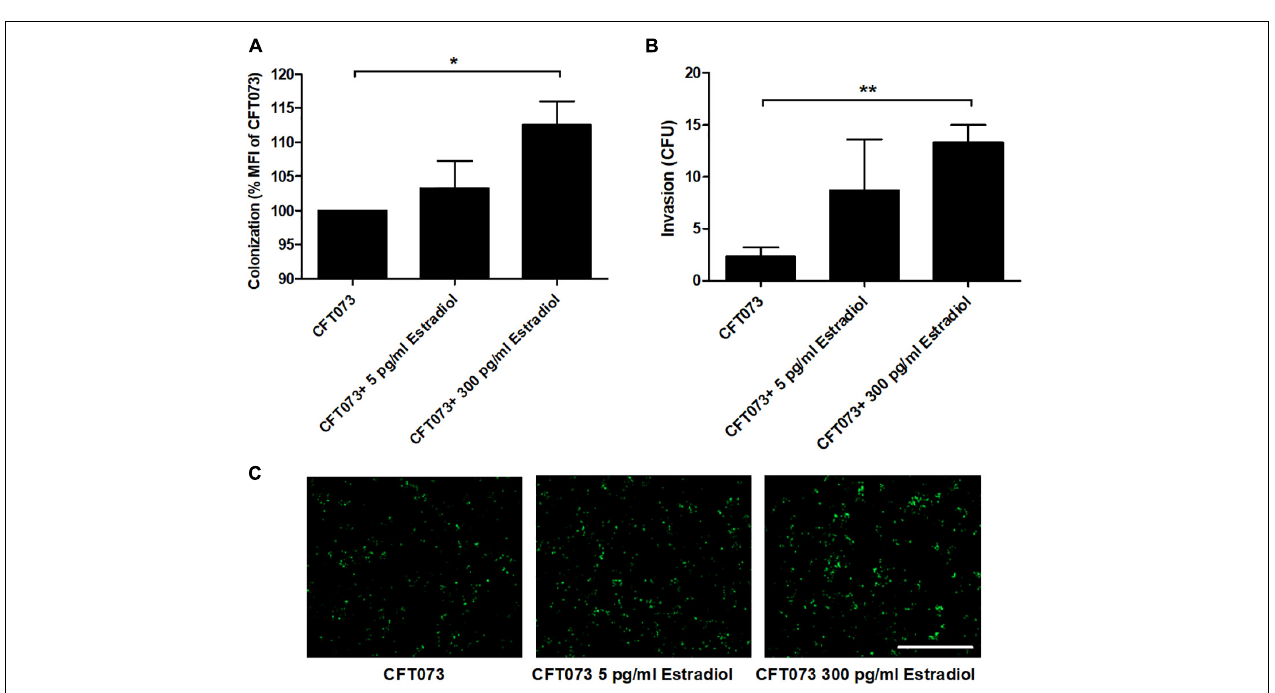
FIGURE 6 | CFT073 colonization ( A , C , 4 h) or invasion ( B , 2 h) of bladder epithelial cells after CFT073 pretreated with or without estradiol (5 and 300 pg/ml). CFT073 (harboring a GFP-expressing plasmid) colonization was quantified as mean fluorescence intensity (MFI) (A) and imaged (C) . Data are presented as mean ± SEM of n = 3 independent experiments. The asterisk distinguishes statistical significance: * p < 0.05, ** p < 0.01 vs. unstimulated CFT073. Scale bar: 200 µ